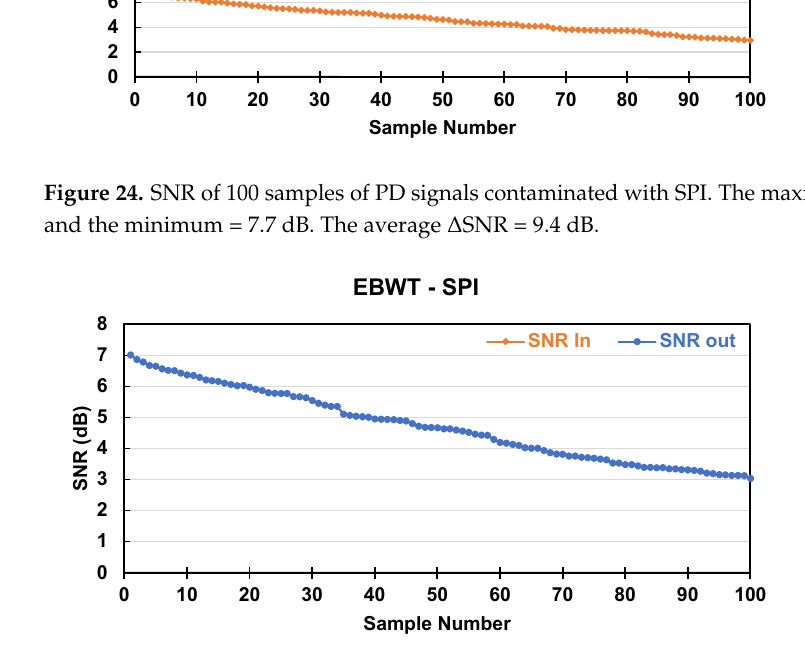
Figure 25. SNR of 100 samples of PD signals contaminated with SPI using EBWT. Very little improve- ment was noticed. The maximum ∆ SNR 0.015 dB and the minimum = 0.0045 dB with an average of 0.0089 dB.